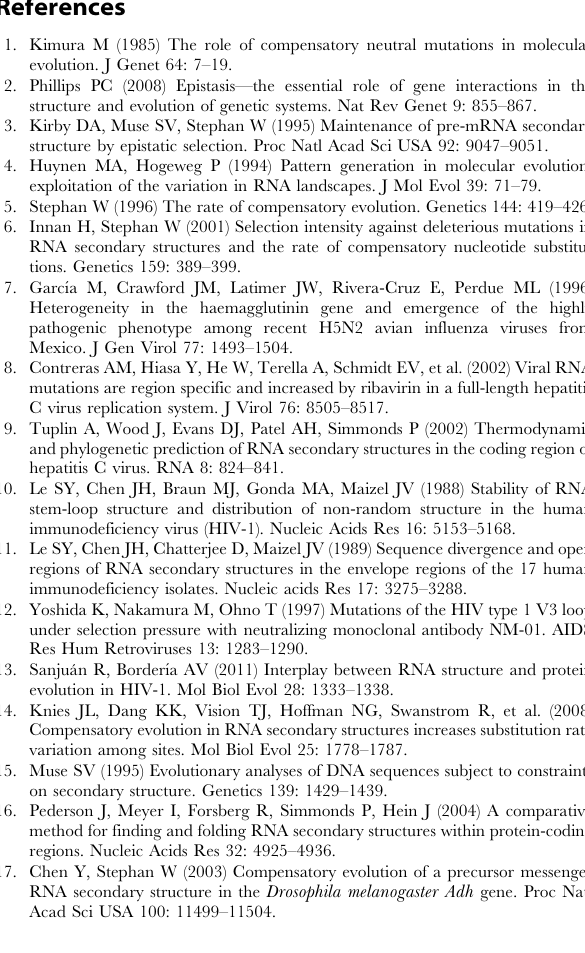
Figure S1 Intra-population frequencies of nonsynonymous nWC and single-site WC replacement polymorphisms in the HIV-1 genome. Frequencies are normalized to enable compari-